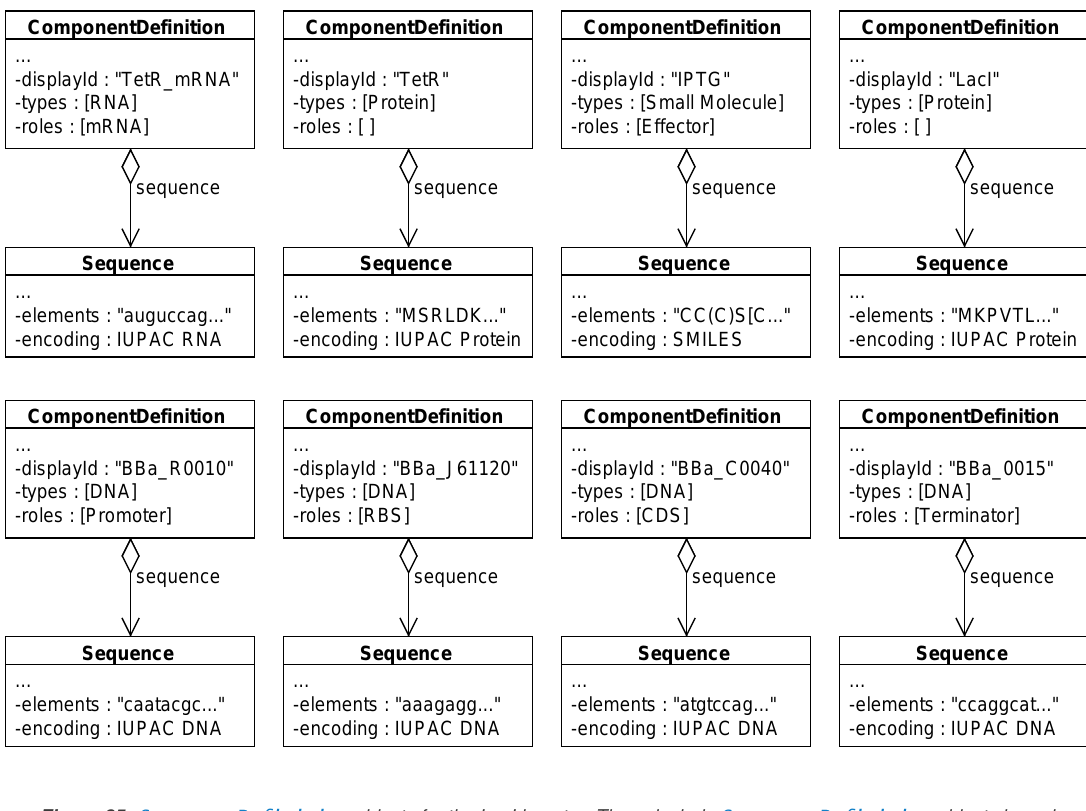
Figure 25: ComponentDefinition objects for the LacI inverter. These include ComponentDefinition objects based on DNA parts from the iGEM Parts Registry and ComponentDefinition objects that represent TetR mRNA, TetR, LacI, and IPTG. Each ComponentDefinition is associated with a Sequence that has an IUPAC DNA/RNA or IUPAC protein encoding , except the ComponentDefinition of IPTG, which is associated with a Sequence that has a SMILES encoding